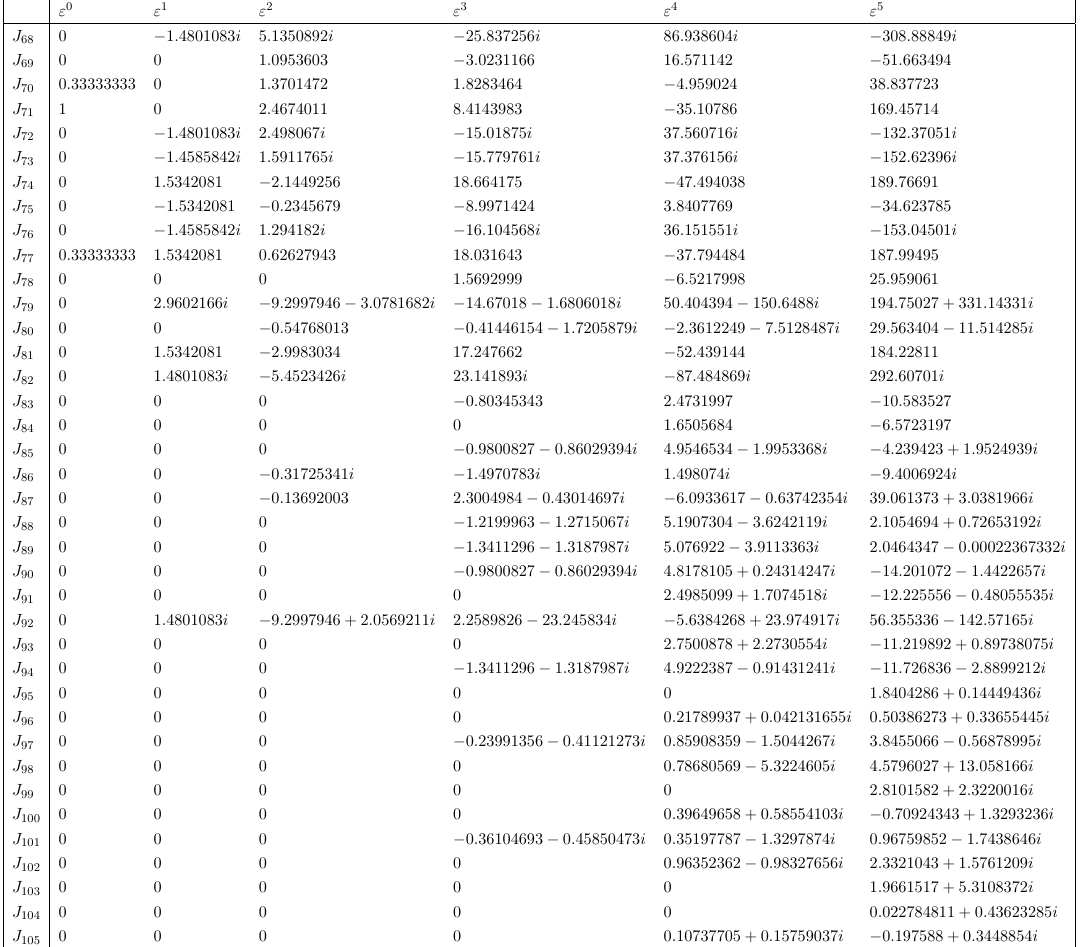
Table 6 . Numerical results for the first six terms of the ε -expansion of the master integrals J 68 - J 105 at the kinematic point p 2 = m 2 H